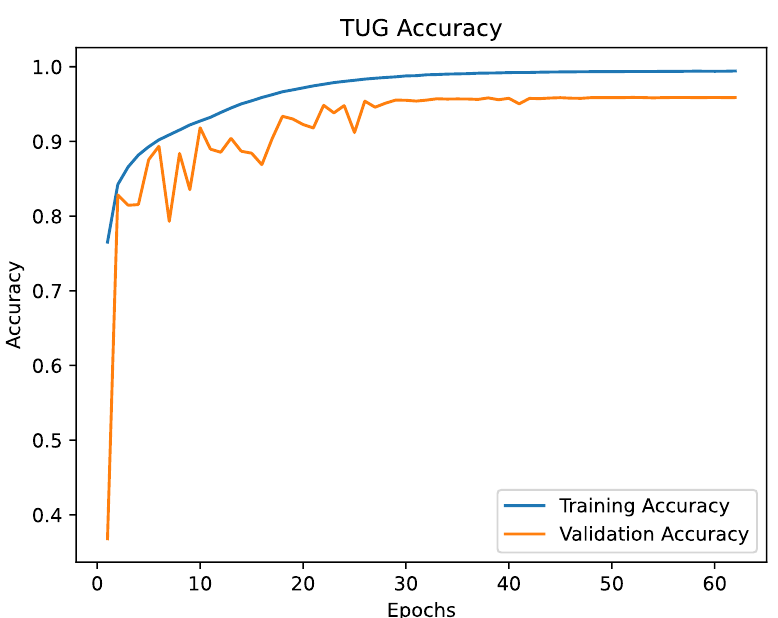
Figure 7. The accuracy of the TUG model. According to the progress of the loss, the accuracy behaviour. Figure 5. The accuracy of the TUG model. fluctuates in the first 25 epochs and shows an asymptotic behaviour after epoch 25. The best validation accuracy score was 95.89% at epoch 52. % at epoch 52.